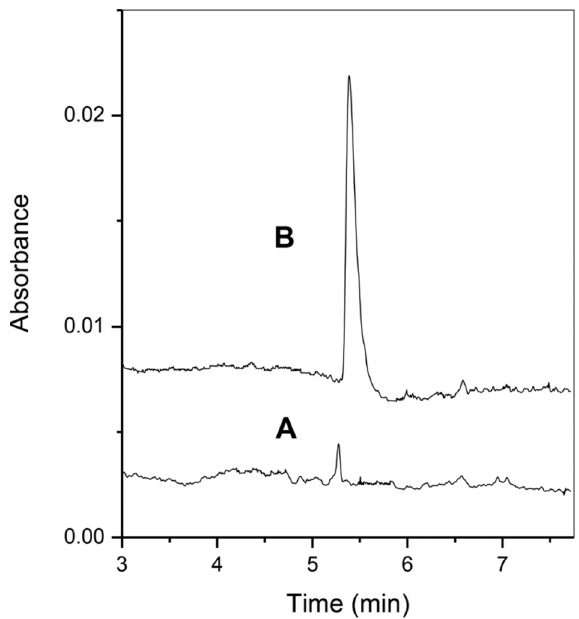
Figure 5. Comparison of ergot alkaloids analysis in rye flour sample before ( A ) and after ( B ) CPE procedure combined with CZE - UV. (Reproduced with permission from Felici, Electrophoresis ; published by Wiley, 2015 [78]).